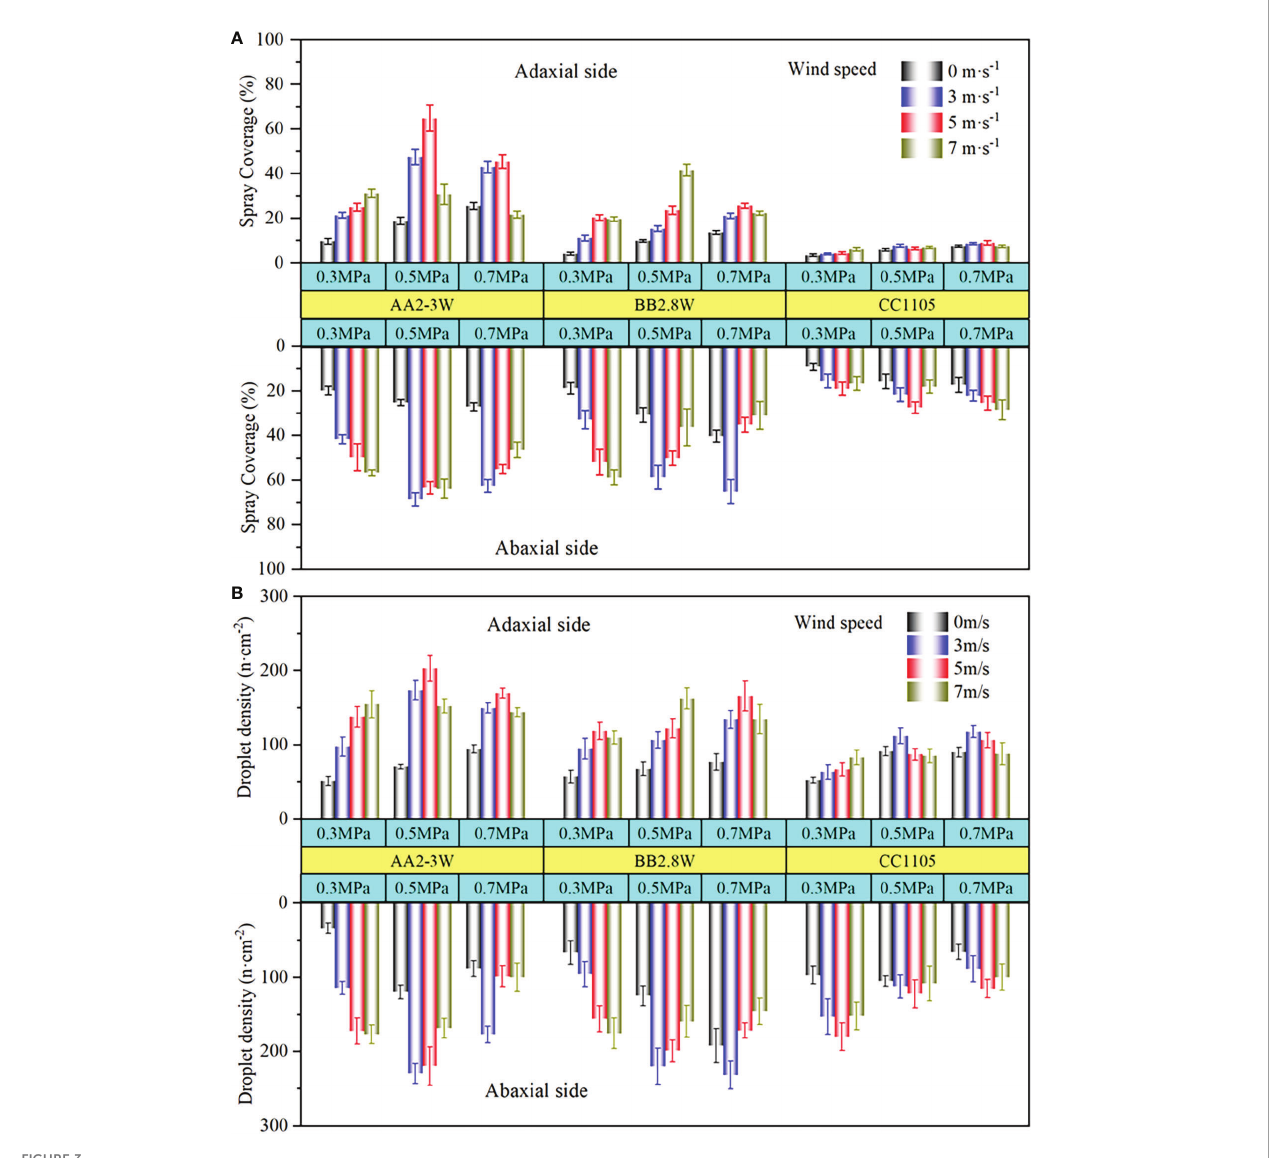
FIGURE 3 The histogram of spray coverage (A) and droplet density (B) on banana leaf